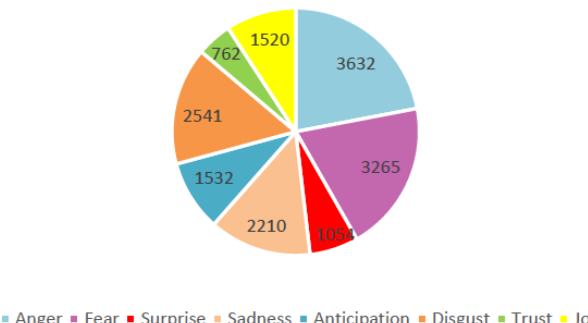
Figure 10: Statistical distribution of emojis on Covid-19 related tweets.